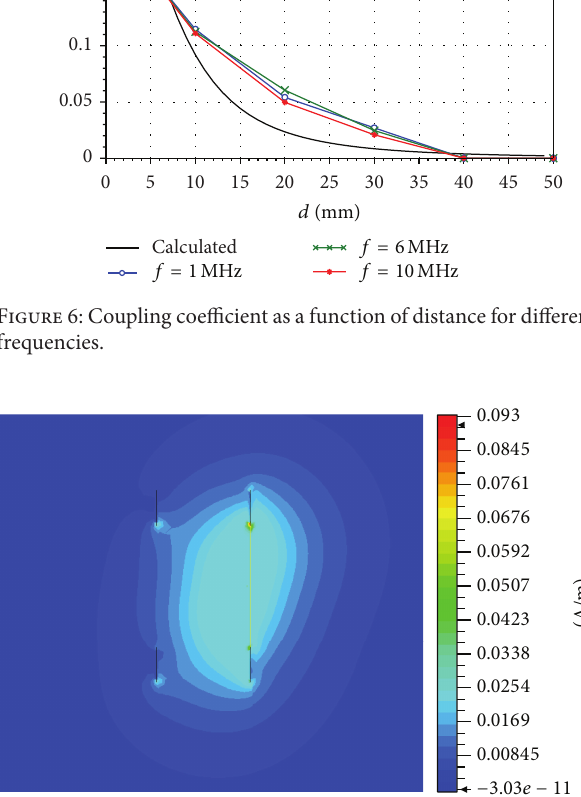
Figure 7: Magnetic field distribution surrounding the coils, in 𝑌𝑍 plane.